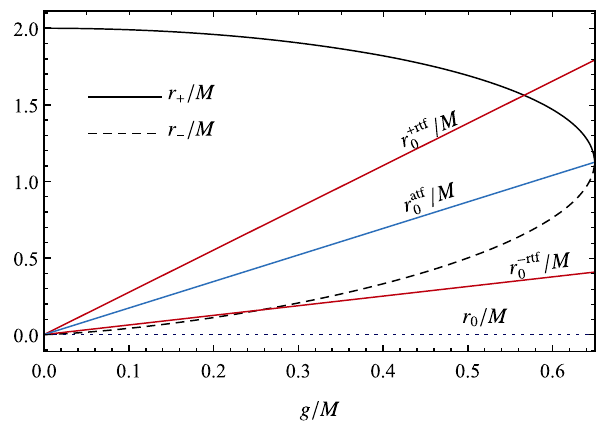
± rtf , r atf ), as functions of the 0 0